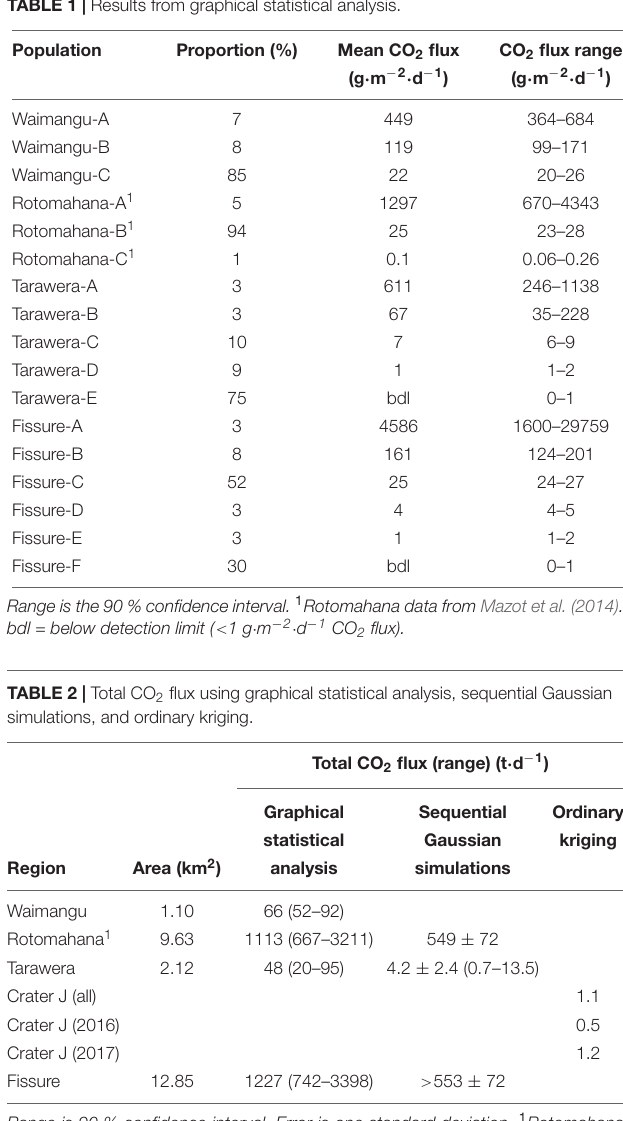
TABLE 1 | Results from graphical statistical analysis.